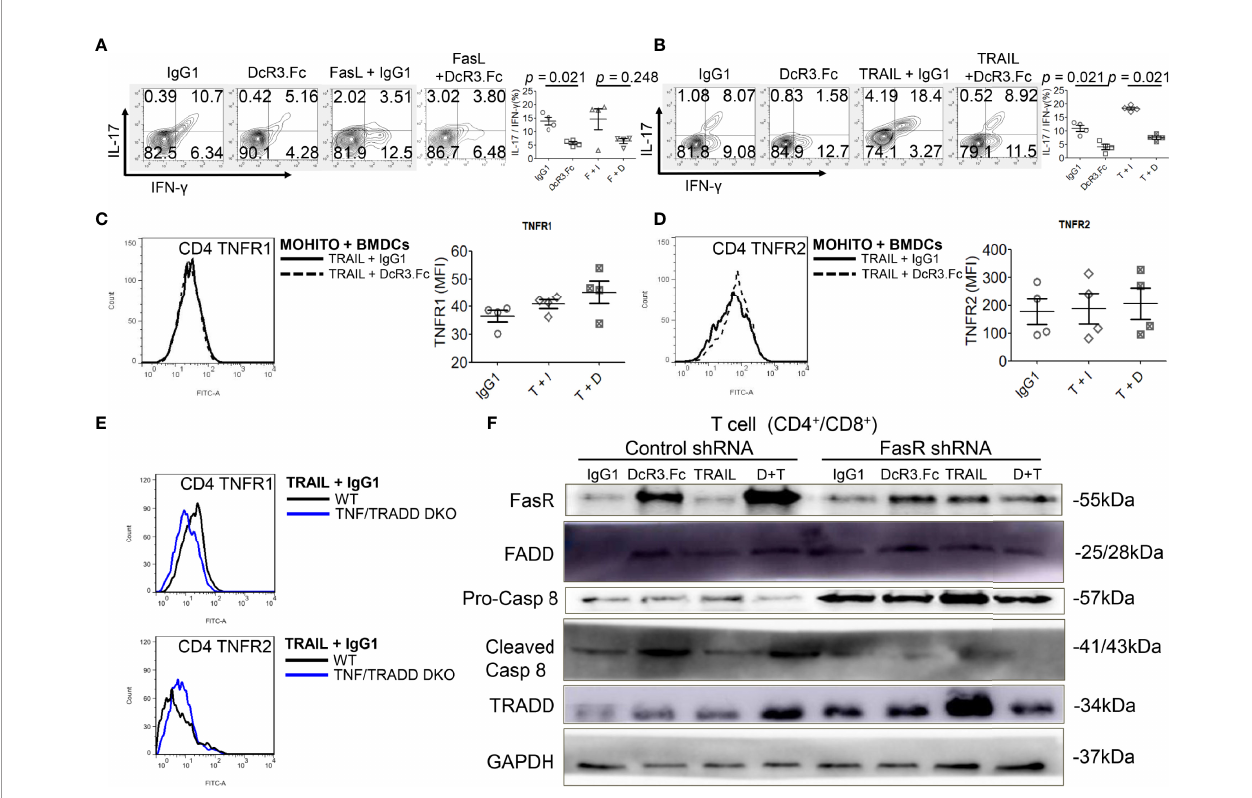
FIGURE 5 | Decoy receptor 3 (DcR3) suppresses the tumor necrosis factor receptor-associated factor 1 (TNFR1) pathway and upregulates FasR/Fas-associated protein with death domain (FADD)/caspase 8 pathway. (A, B) Interleukin-17 and interferon- g production by bone marrow-derived dendritic cell (BMDC)-activated MOHITO T-cells co-treated with or without FasL/TRAIL was measured using intracellular cytokine staining. Right panel, a dot graph of T-cells treated with IgG1, DcR3.Fc, FasL/TRAIL+IgG1, and FasL/TRAIL+DcR3.Fc for 36 h. (C) TNFR1 expression. Right panel, mean fl uorescence intensities (MFI) of isotype controls and stimulated samples. (D) TNFR2 expression. Right panel, MFI of isotype controls and stimulated samples. (E) TNFR1 and TNFR2 expression in CD4 + T-cells of WT and TNF/TNFR1-associated death domain protein (TRADD) double knockout (DKO) mice. The cells were double-stained with anti-mCD4-allophycocyanin – cyanine7 (cy7)/TNFR1-FITC or TNFR2-FITC. (F) FasR/FADD/TRADD/caspase 8 pathway and Fas shRNA on the MOHITO cell lines. All experimental models among female WT, female TNF/TRADD DKO, and MOHITO (immortalized CD4 + CD8 + T-cell line, BALB/c origin) T-cells are BMDCs (male C57BL/6 origin) + LPS-activated method for 36 h. Lower pro-caspase 8 was found in immortalized T-cells co-treated with IgG1, DcR3.Fc, TRAIL+IgG1, TRAIL+DcR3.Fc, and FasR shRNA; immortalized T- cells co-treated with IgG1, TRAIL, and control shRNA indicate no triggering apoptosis of effector T (Teff) cells. F, FasL; I, human IgG1; D, DcR3.Fc; T, TRAIL; DcR3.Fc 10 m g/ml; FasL 100 ng/ml; TRAIL 100